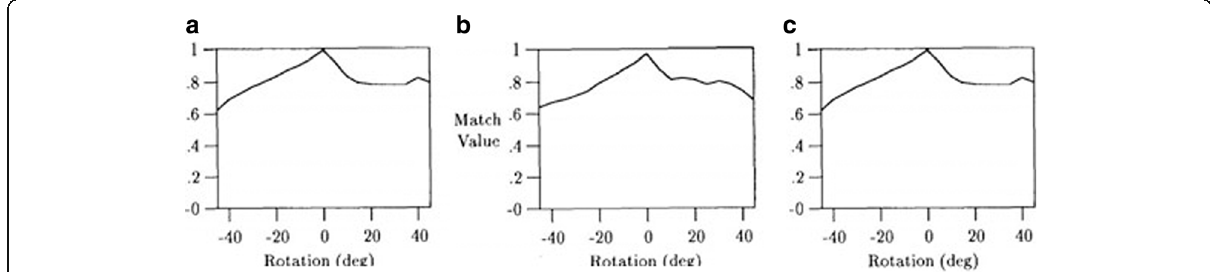
Fig. 3 Histogram match value variation graph related to camera variations, ( a ) distance variation effect, ( b ) rotation to left and right effect, ( c ) rotation to up and down effect